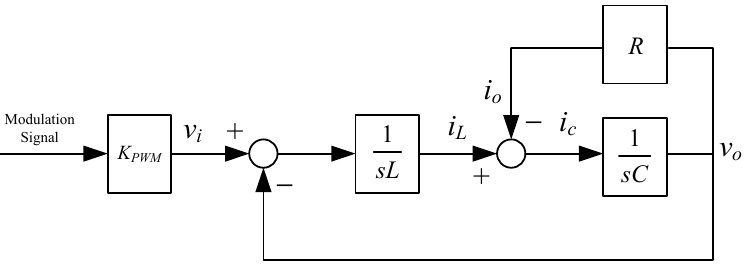
filter and load can be transformed into the block diagram shown in Figure 2. Figure 1. Circuit of PWM voltage source inverter.